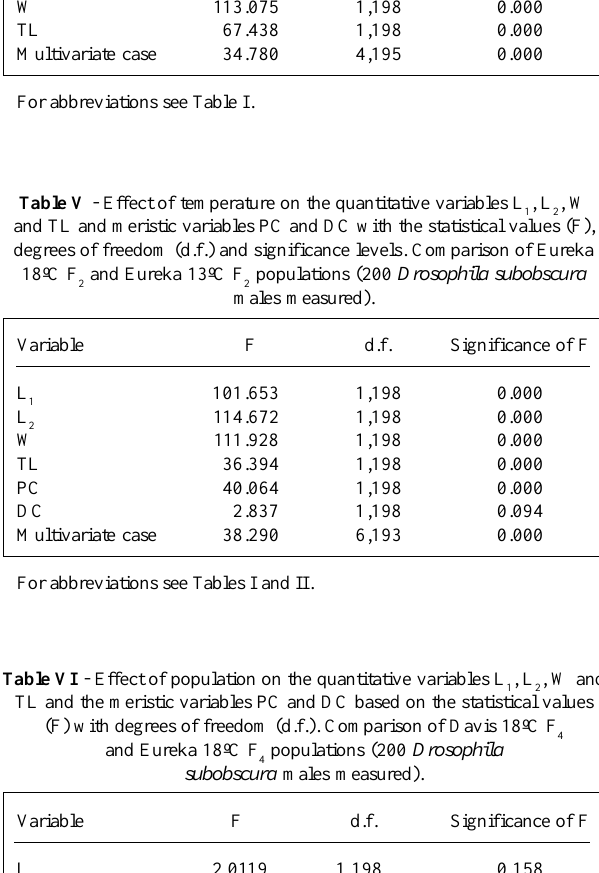
and Davis 18ºC F 2 4